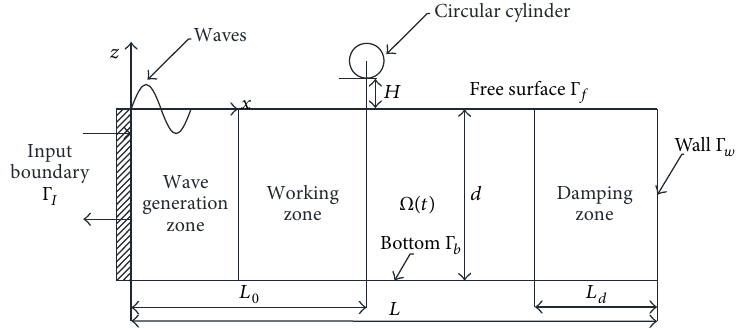
Figure 1: Numerical wave tank and a moving circular